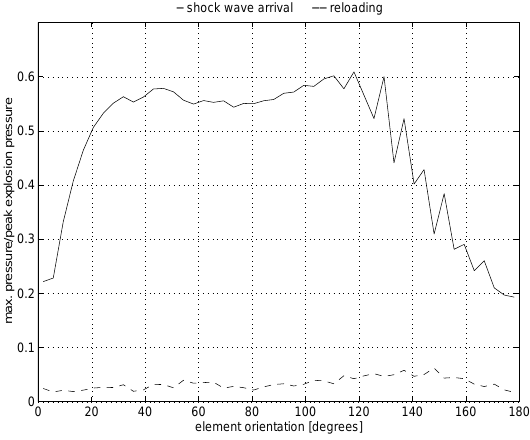
Fig. 8. Maximum hull pressures during shock wave arrival (solid line) and reloading (dashed).